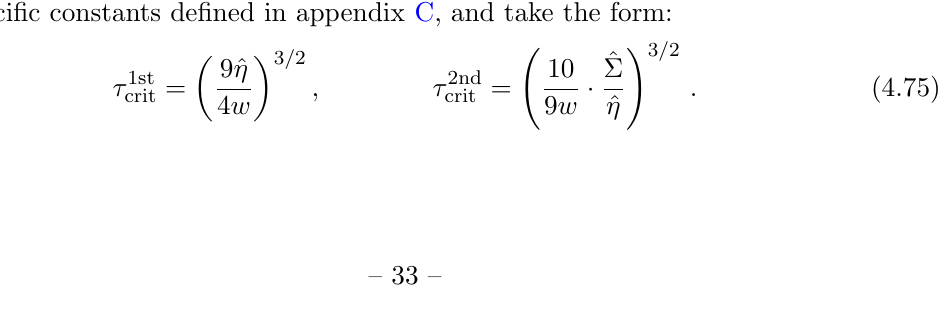
Figure 7 . Plots for ~ S (1) f 0 ; 0 : 3 ; 0 : 6 ; 0 : 9 g depicted in blue, orange, green and red, respectively. Solid lines correspond to (cid:21) = 0 (Einstein gravity) while the dashed lines correspond to (cid:21) GB corresponds to (cid:12)rst-order hydrodynamics, while the plot on the right corresponds to second-order